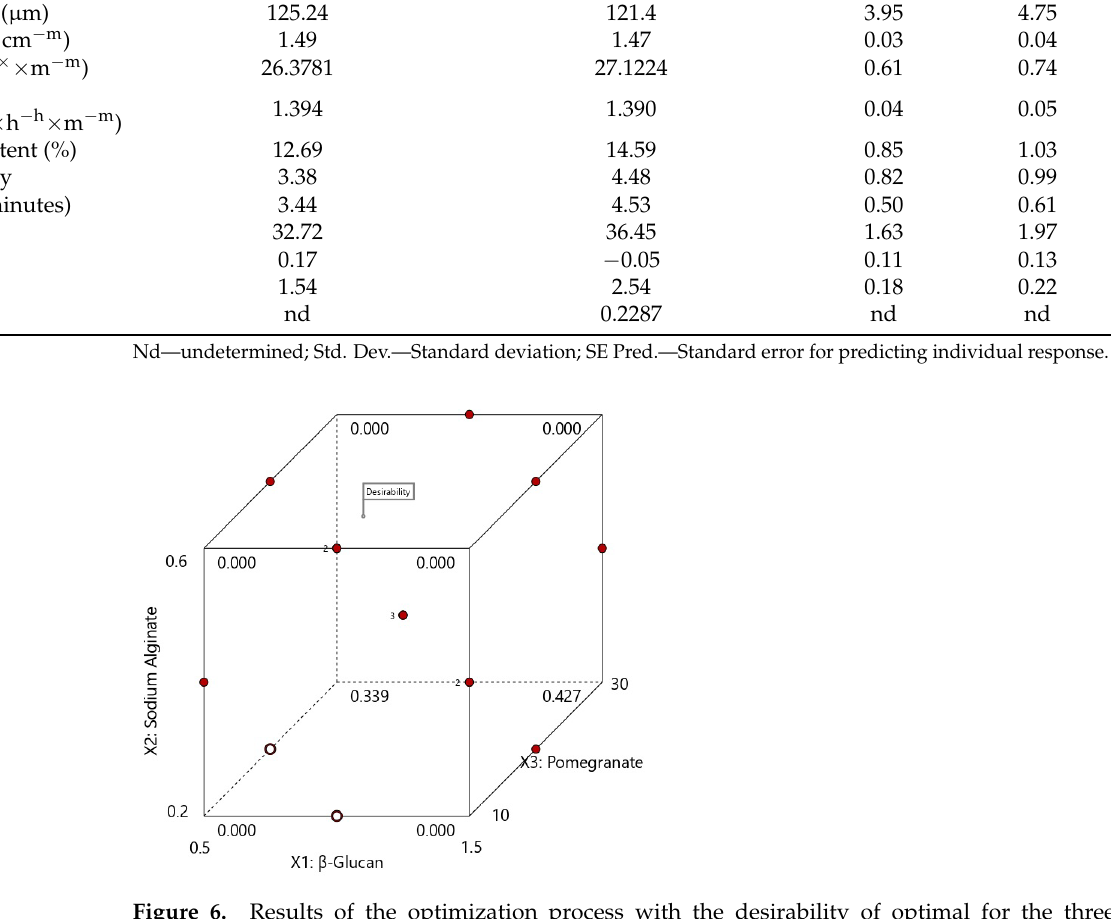
Figure 6. Results of the optimization process with the desirability of optimal for the three variables investigated. variables